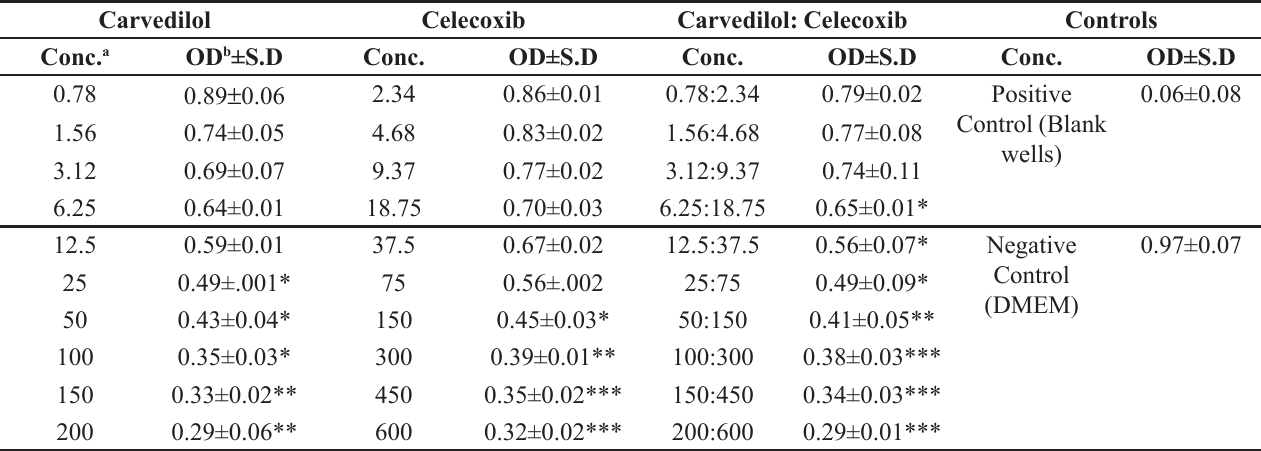
c Concentration =µg/ml, b OD= Mean optical density of the cells against the control exposed to that concentration in terms of mean± standard deviation. Statistical significance was analyzed using the two-way ANOVA followed by Post Hoc Duncan, *P <